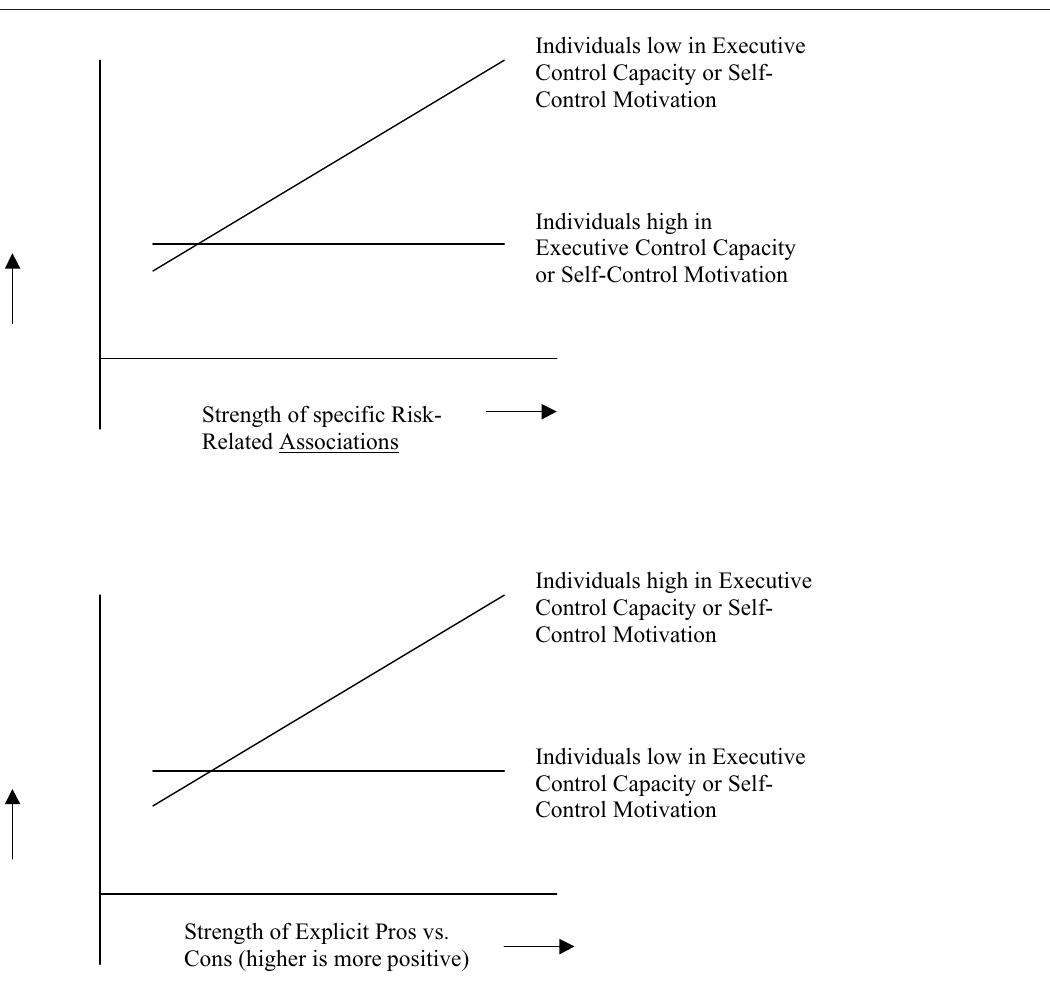
Figure 1 | Typical pattern of result from moderation studies (see main text for many examples of